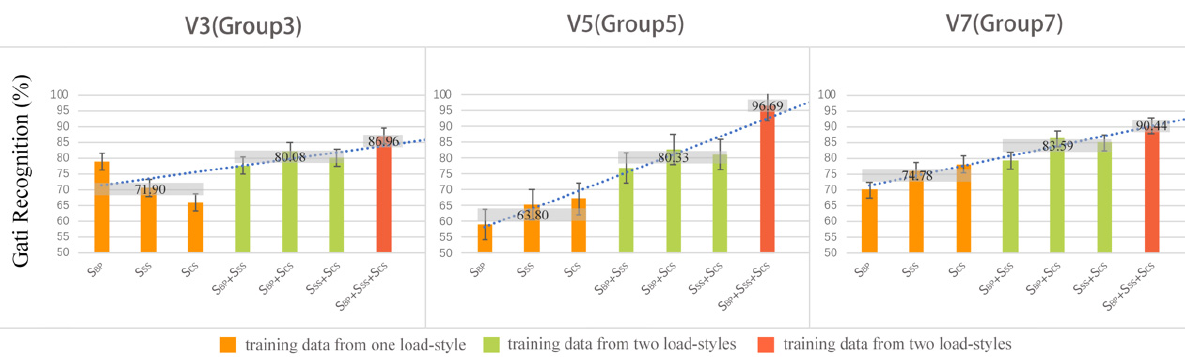
Figure 5. The average accuracies of the gait recognition (%) for one, two, three, and four loads at each speed are labelled in the figure.